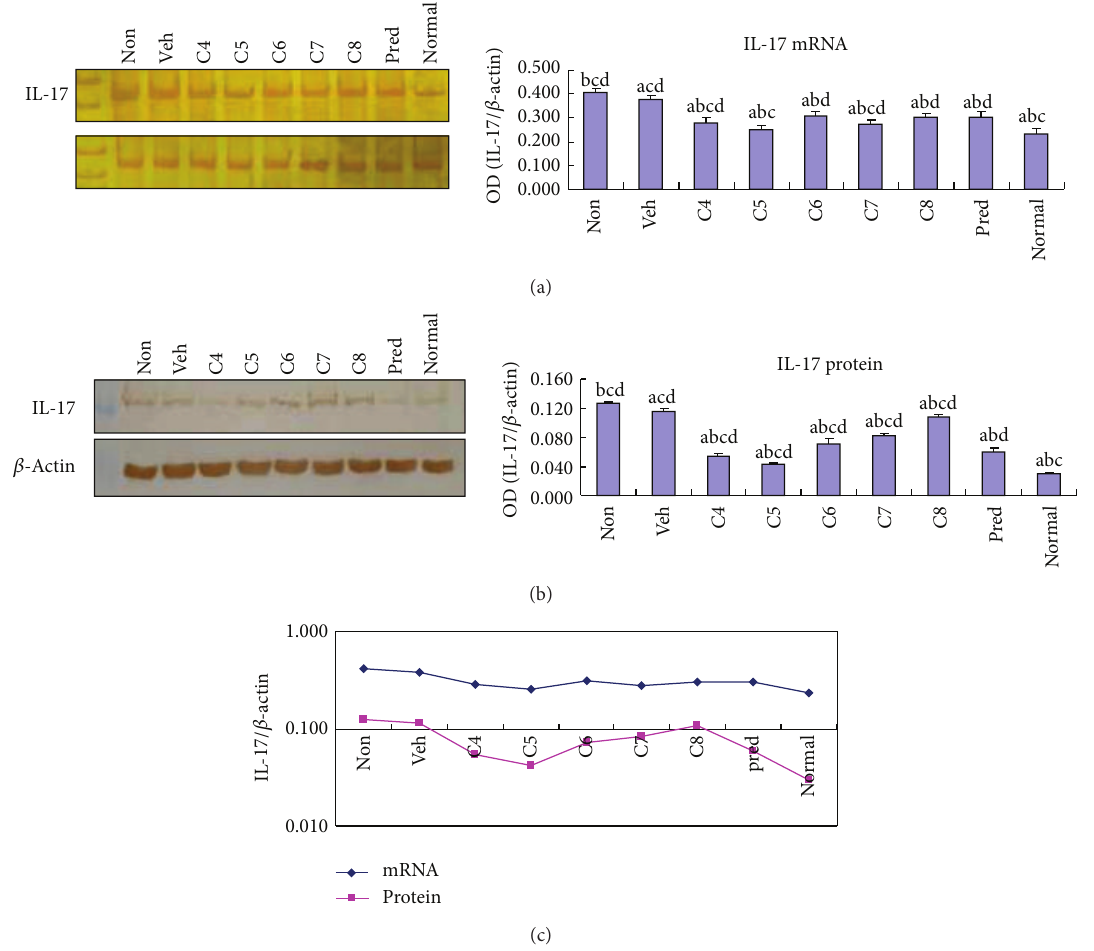
Figure 1: Oral administration of Lactobacillus acidophilus inhibited IL-17 expression in DSS-induced colitis. The mRNA (a) and protein (b) levels of IL-17 expression were examined by RT-PCR and Western blotting, respectively, in the colonic tissues of normal control mice group (normal) and DSS-induced mice groups, including L. acidophilus- treated groups C4–C8 (oral gavage of 10 4 , 10 5 , 10 6 , 10 7 , or 10 8 CFU/10g body weight, resp.), prednisone acetate treated positive control (Pred), and nontreated (Non) and vehicle (Veh) treated control groups. Representative electrophoresis images are shown on the left, and bar graphs presenting mean ± SD ( 𝑛 = 8 ) values are shown on the right. A plotted trendline chart shows IL-17 expression in each group at both mRNA and protein levels (c). a 𝑃 < 0.05 versus Non, b 𝑃 < 0.05 versus Veh, c 𝑃 < 0.05 versus Pred, and d 𝑃 < 0.05 versus